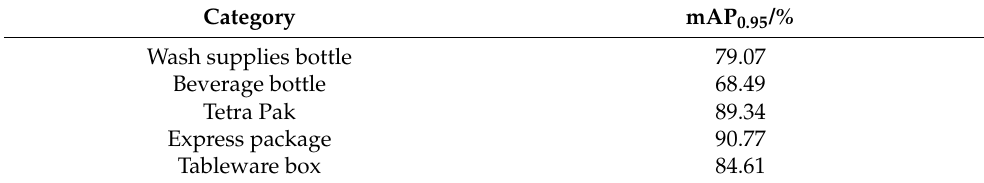
Table 3. mAP of each category.